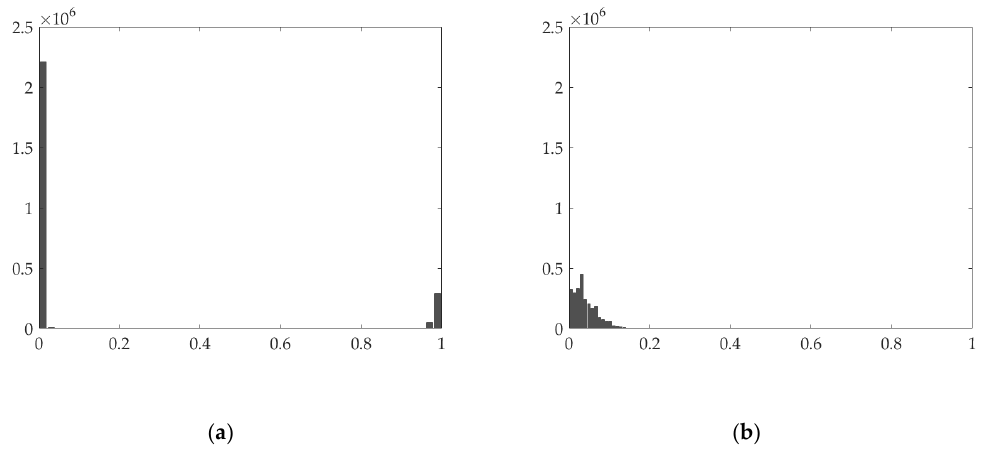
Figure 5. The histogram of the absolute values of the temporal gradient of ( a ) cloud/shadow element and ( b ) clean element.